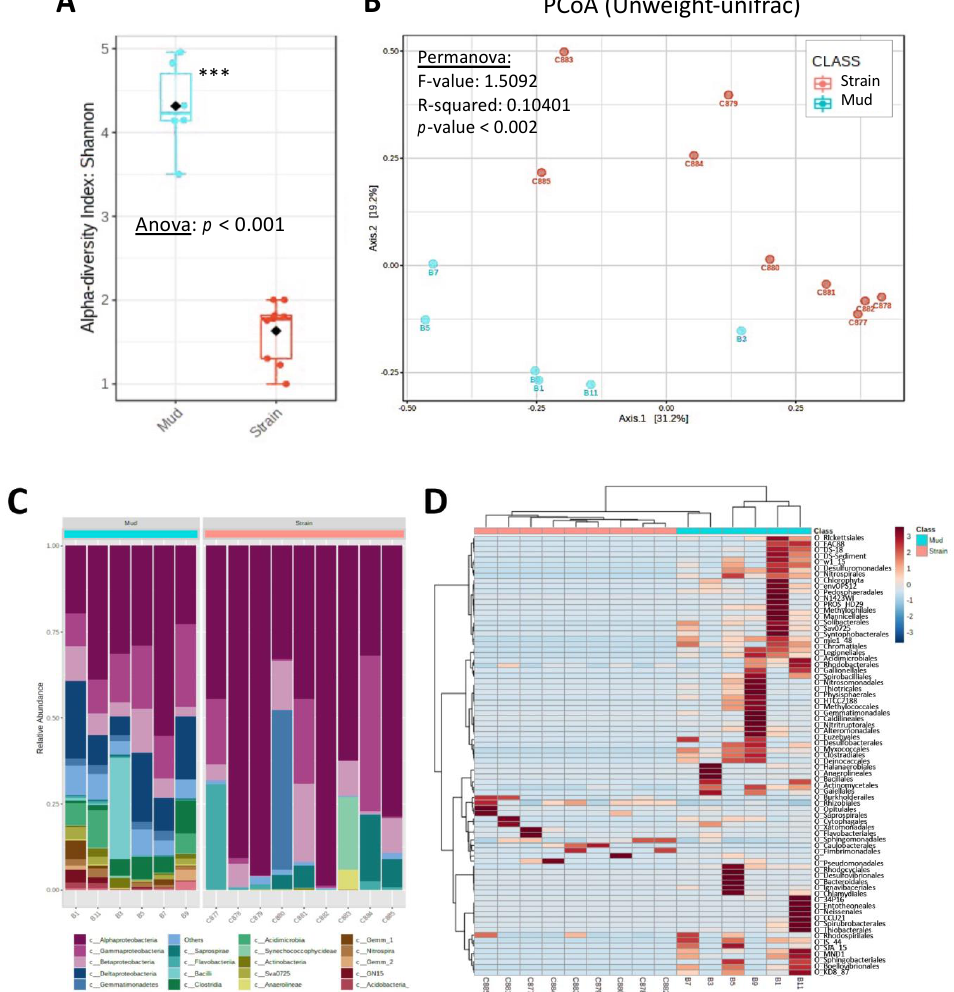
Figure 4. Bacterial diversity of the Balaruc’s biofilm muds ( n = 6, turquoise) and cyanobacterial strains ( n = 9, pink) by 16S rRNA metabarcoding. ( A ) Alpha diversity analyzed with Shannon’s index. ( B ) Beta diversity analyzed on PCoA performed with unweight-Unifrac distance and Per- manova analysis. ( C ) Relative proportion of all principal heterotroph bacterial orders. C877–C885 indicates PMC 877–885 strains. ( D ) Heatmap with hierarchical classification (Euclidean distance) of dominant ASV (<0.1%), with the color scale representing respective abundancies. *** indicate Anova p -value <